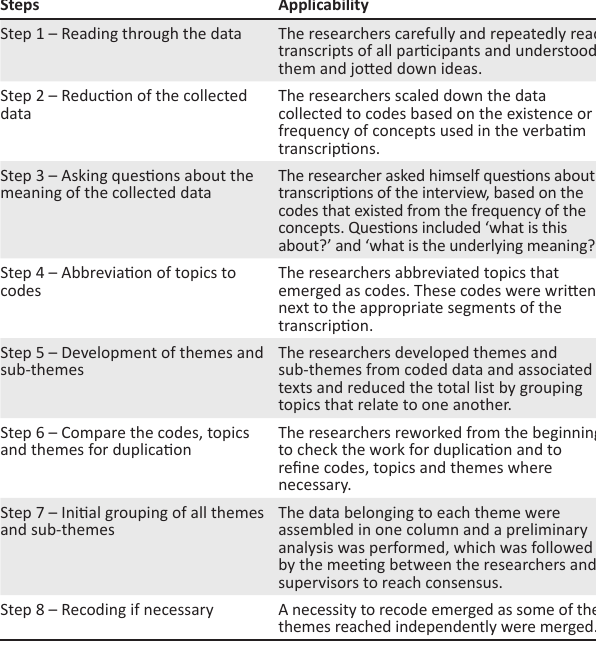
TABLE 2: Tesch’s eight steps of open coding. Steps Applicability